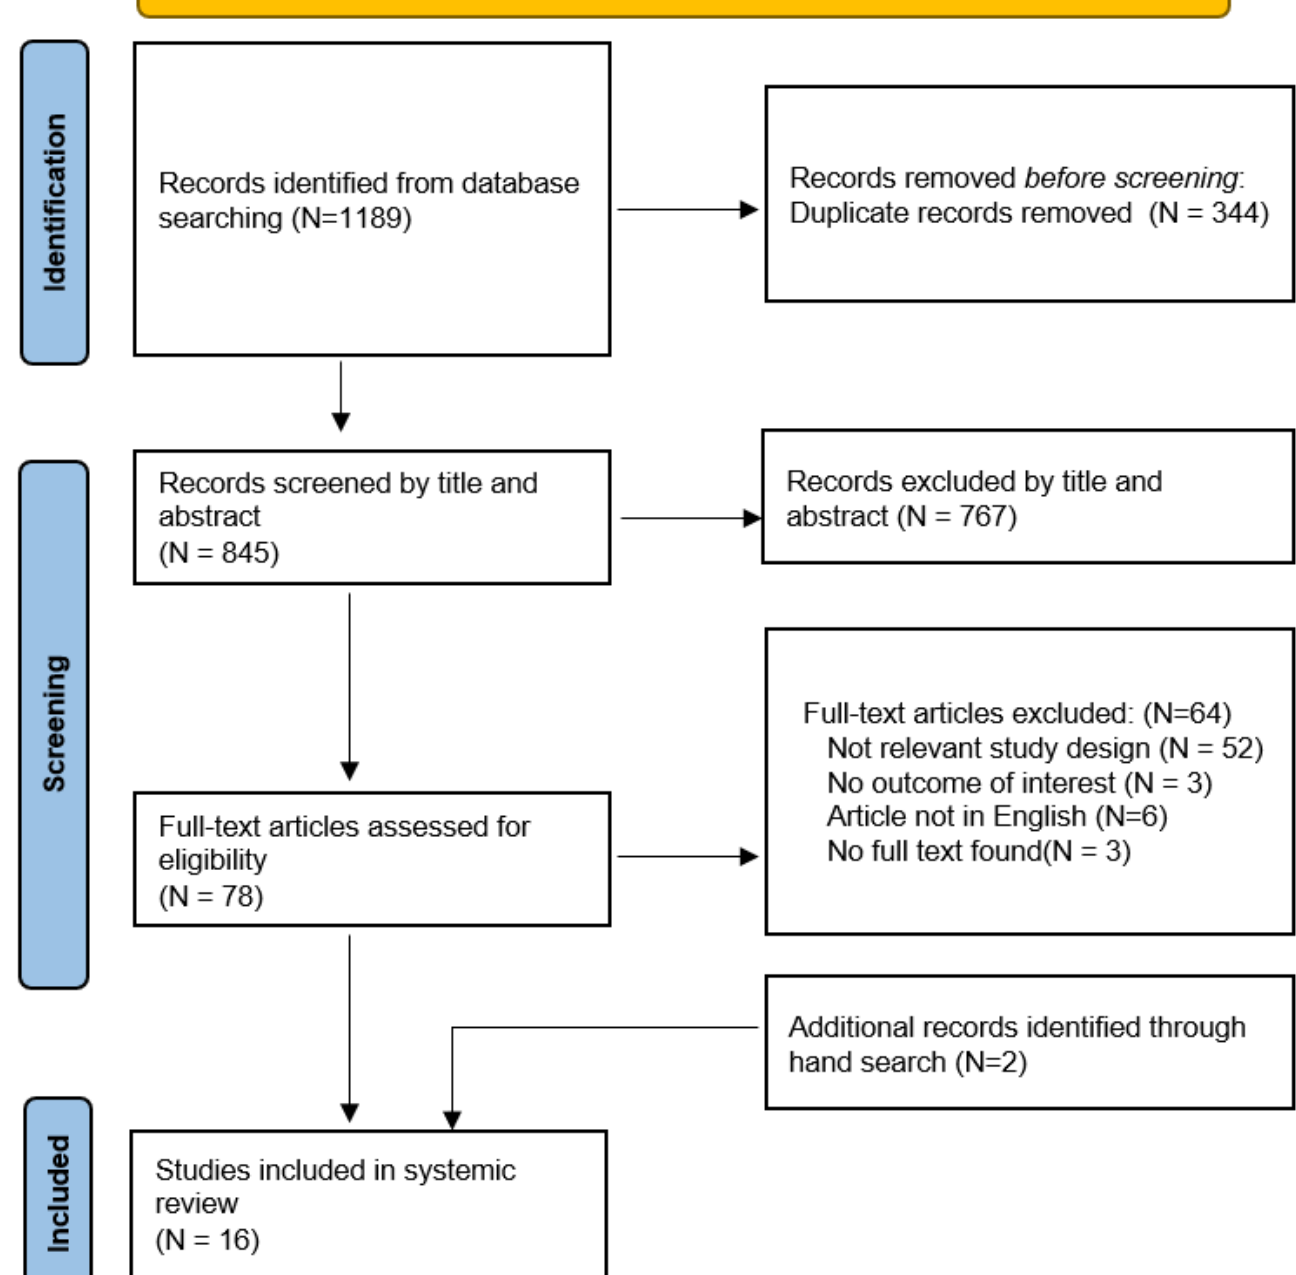
Figure 1. Flowchart of literature search and selection.